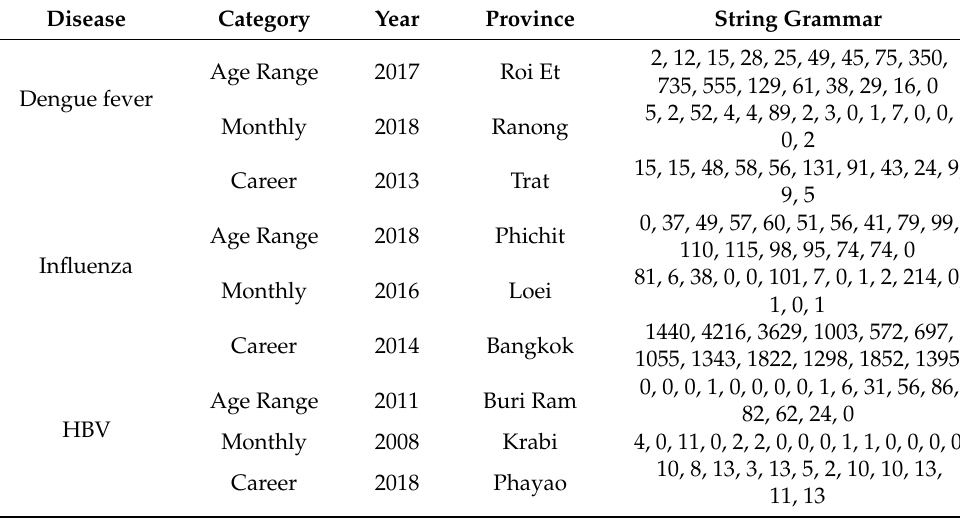
Table 4. Example of generated string sequences.